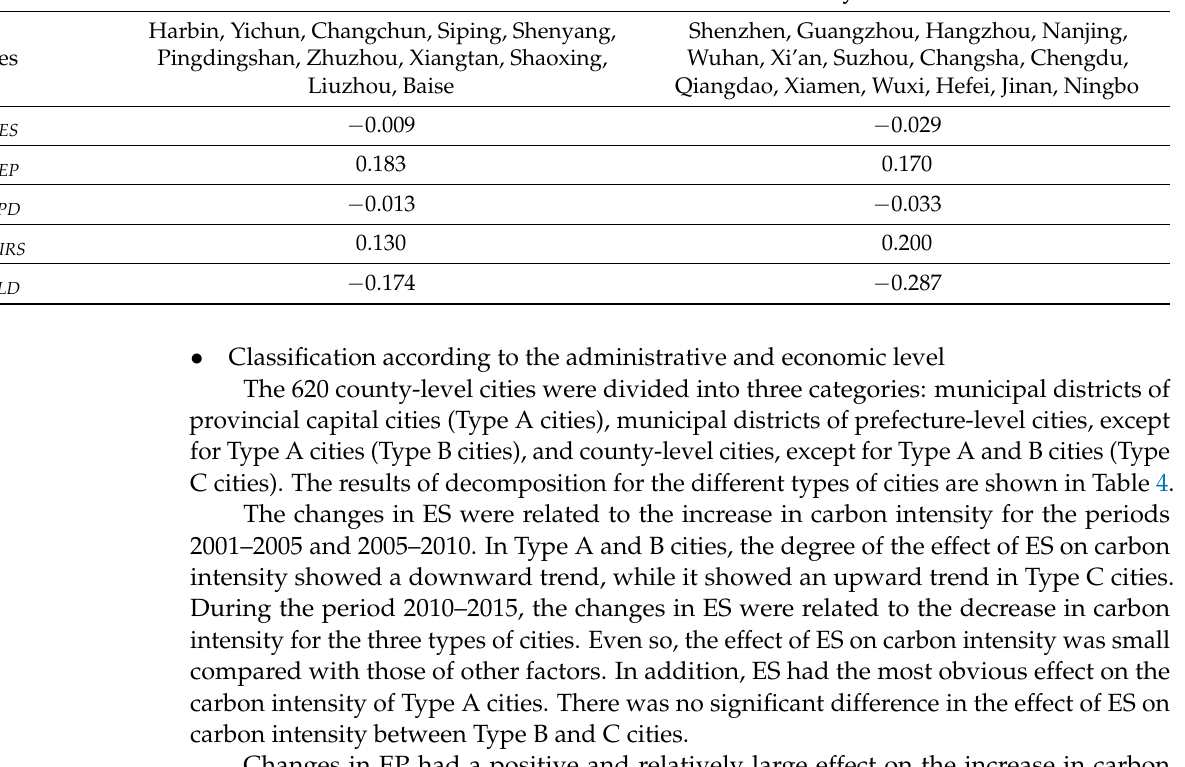
Table 3. Decomposition results for different types of industrial cities during 2010–2015 (tCO 2 /(10 4 yuan)).